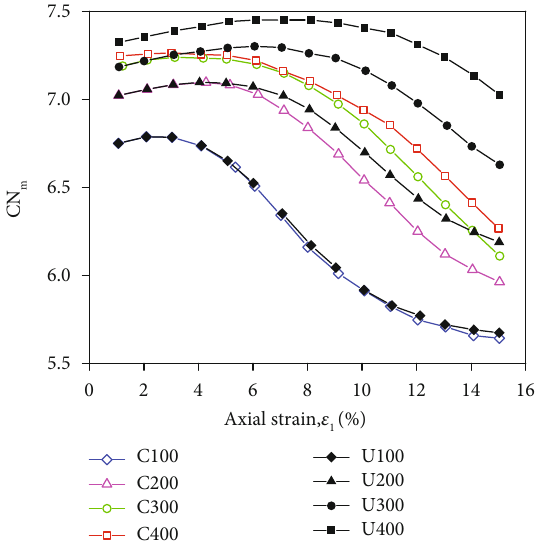
Figure 6: Evolution curve of mechanical coordination number of sample.